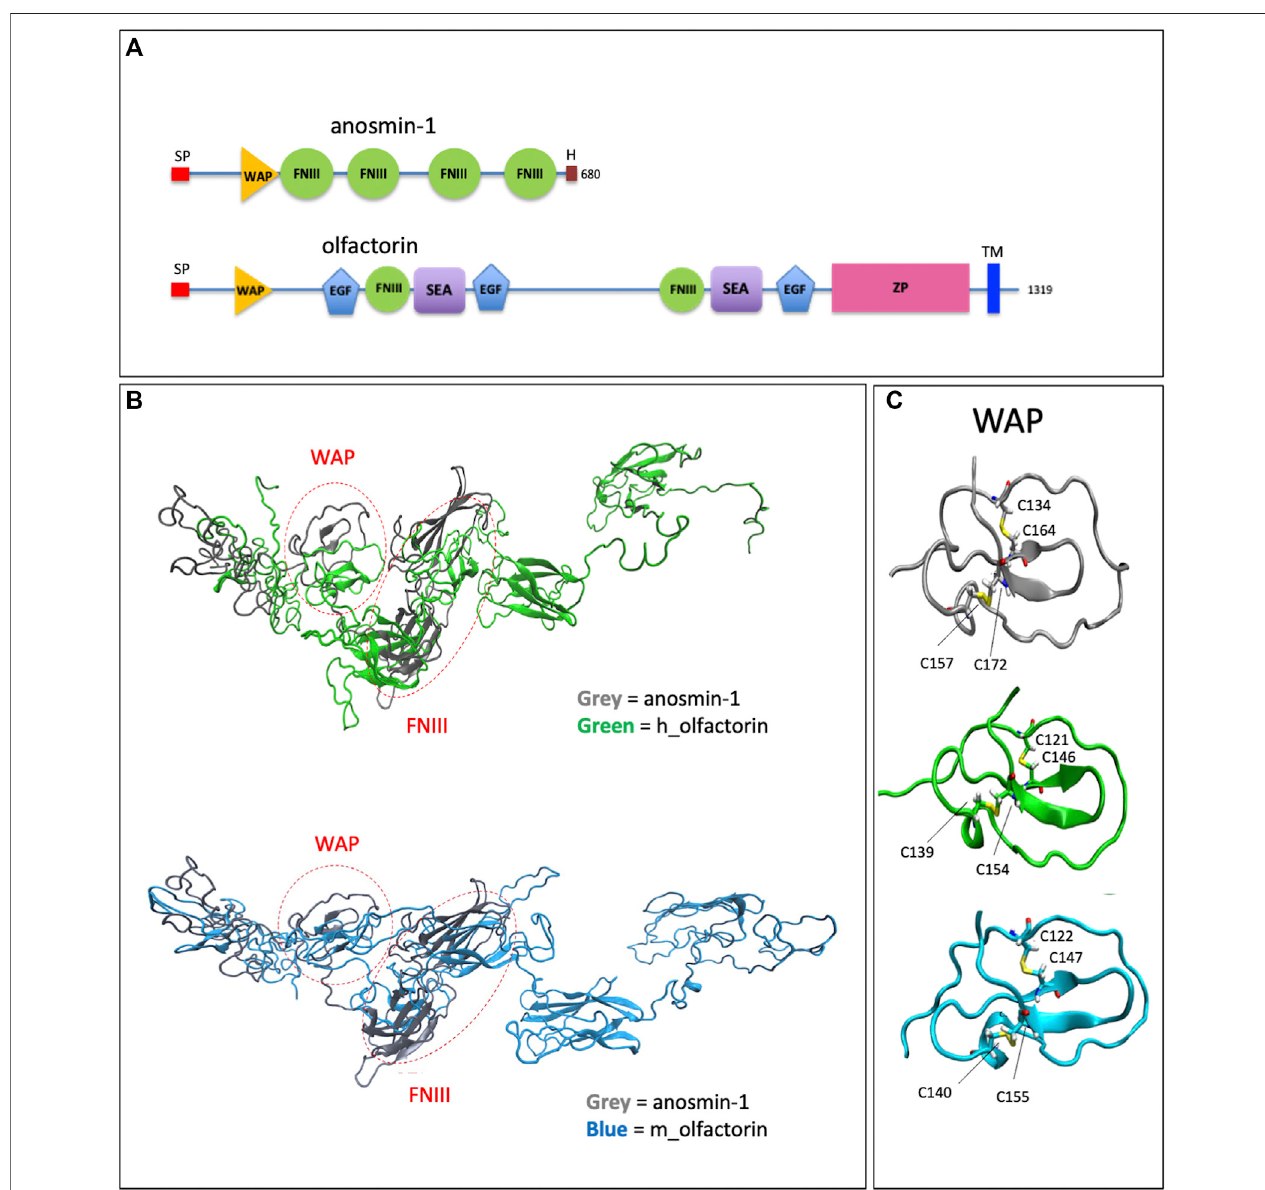
FIGURE1| Structuraldomainsofolfactorinandanosmin-1andanalysisoftheirN-terminalregion. (A) Theschematiccomparisonofthestructuresandofthemain protein domains of anosmin-1 and olfactorin. (B) The ribbon representation of the domain solution structure model of human (green) and mouse (blue) olfactorins showing a similarity with human anosmin-1 (grey) in the N-terminal region of the molecules with common WAP (whey acidic protein-like) and FNIII ( fi bronectin type III) domains. (C) The ribbon representation and comparison of the WAP domains; the corresponding cysteine (C) residues forming disapplied bridges are evidenced. Abbreviations: EGF, calcium-binding EGF-like domain; FNIII, fi bronectin type 3 domain; H, histidine-rich regions; SEA, sea urchin sperm protein; SP, signal; TM, transmembrane domain; WAP, whey acidic protein domain; ZP, zona pellucida domain.